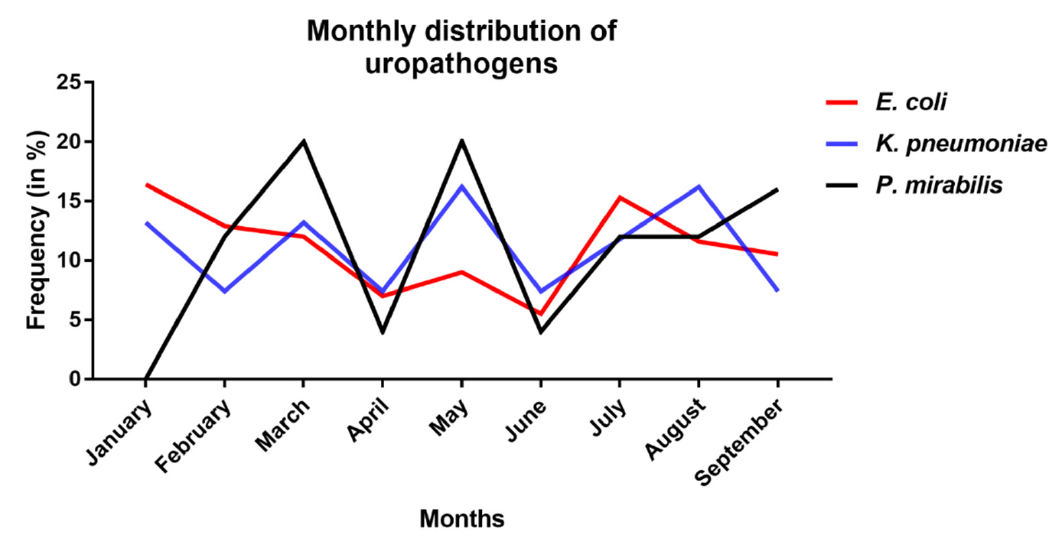
Figure 1. Monthly distribution of di ff erent uropathogens from January to September 2017 in UTI patients. E. coli (in red), K. pneumoniae (in blue), and P. mirabilis (in